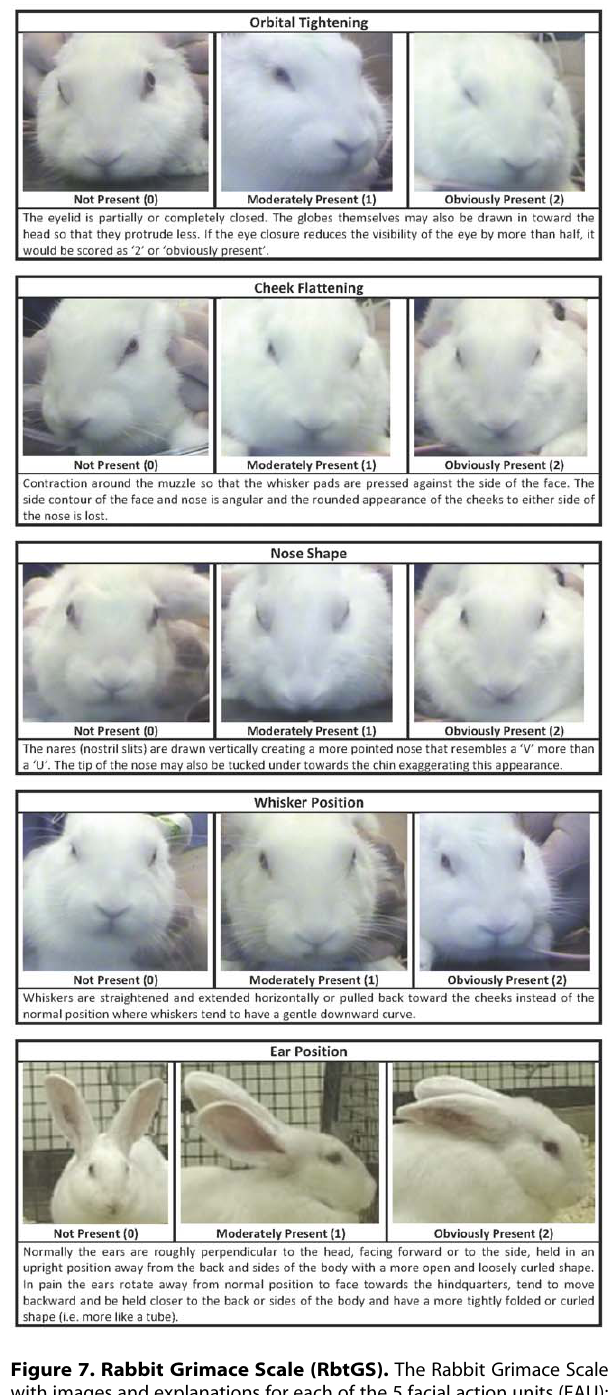
Figure 7. Rabbit Grimace Scale (RbtGS). The Rabbit Grimace Scale with images and explanations for each of the 5 facial action units (FAU); orbital tightening, cheek flattening, nose shape, whisker position and ear position. Each FAU is scored according to whether it is not present (score of 0), moderately present (score of 1) and obliviously present (score of